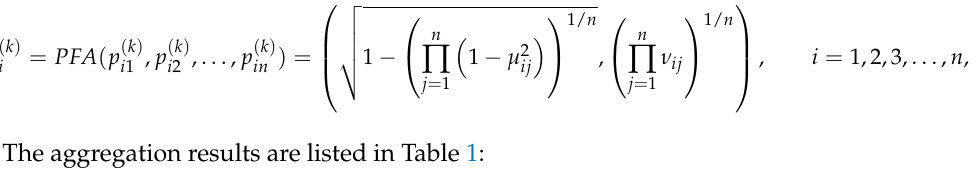
Table 1. The aggregation results of the experts e k ( k = 1,2, . . . ,6 ) . Experts The Overall Results of the